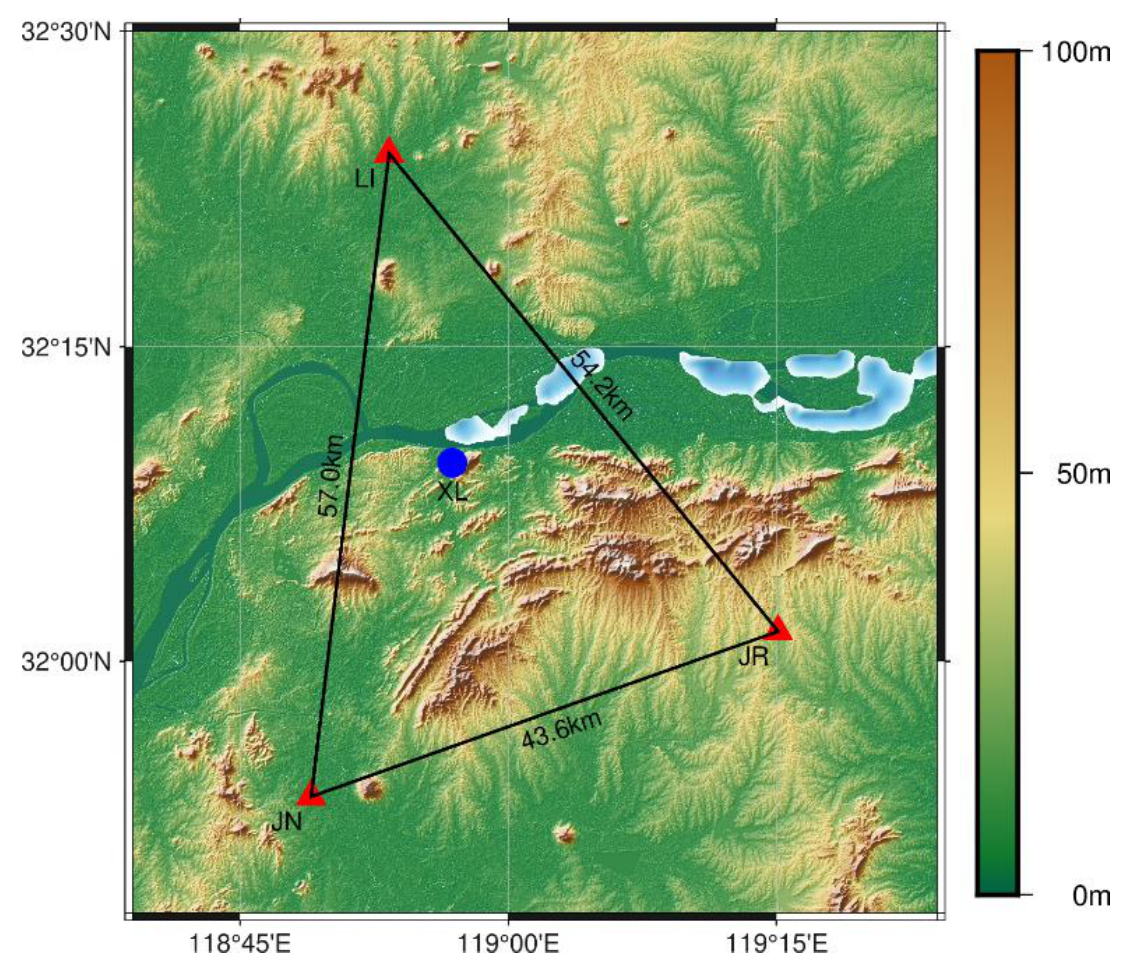
Figure 11. Distribution of second CORS and user station. Figure 12 shows the ambiguity fixing success rate of three baselines for seven consecu- tive days under the two models. The three bars, from left to right, for each day represent baseline JN-JR, JN-LI, and JR-LI, respectively. It can be seen from the figure that the QFIW model had a better success rate than the TFGB and DFIF models for all baselines on all days. The success rate increased from 94.4 and 96.1% to 98.0% compared with the DFIF and TFGB models.